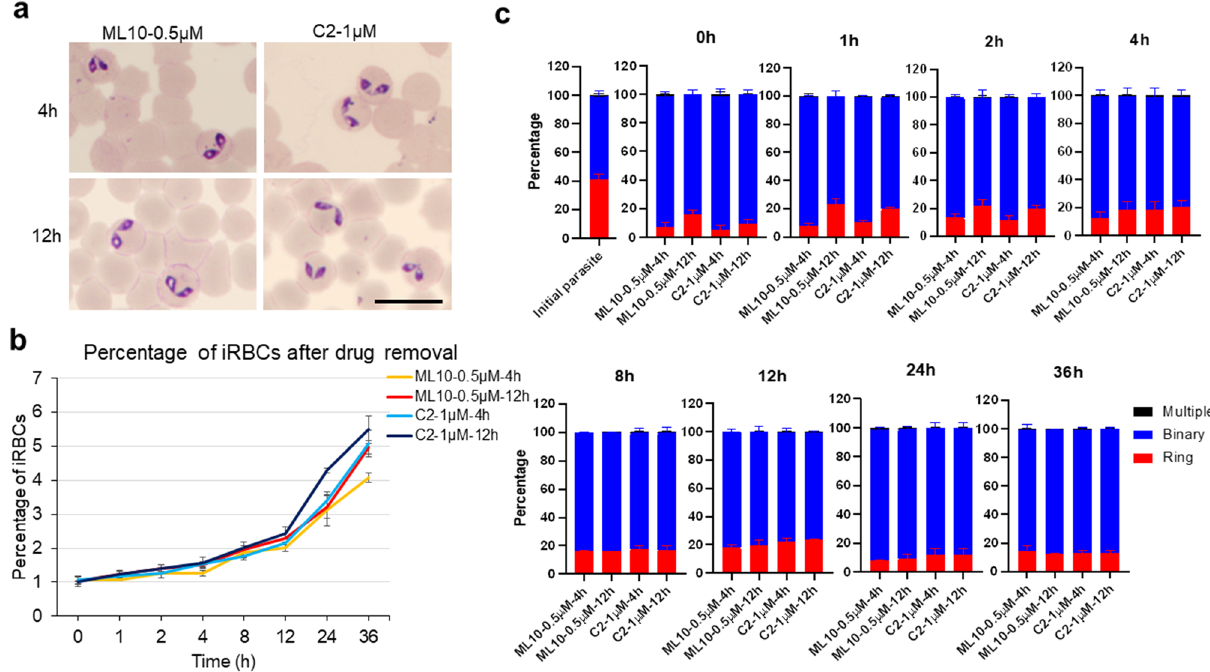
Figure 4. Babesia bovis growth and egress following removal of C2 and ML10. ( a ) The Giemsa-stained smears were prepared before drug removal to validate the effects of drugs on parasite morphology. Scale bar = 10 µm. ( b ) Parasites that had been arrested in the culture in the presence of 0.5 μM of ML10 or 1 μM of C2 for 4 or 12 h were washed and transferred to fresh medium to allow egress and invasion of new RBC for 36 h. The data are shown as mean ± S.D. of triplicate culture. ( c ) Proportion of ring, binary, and multiple stages in initial parasites, at the time and following removal of ML10 or C2 were calculated for 36 h (mean ± S.D. of triplicate